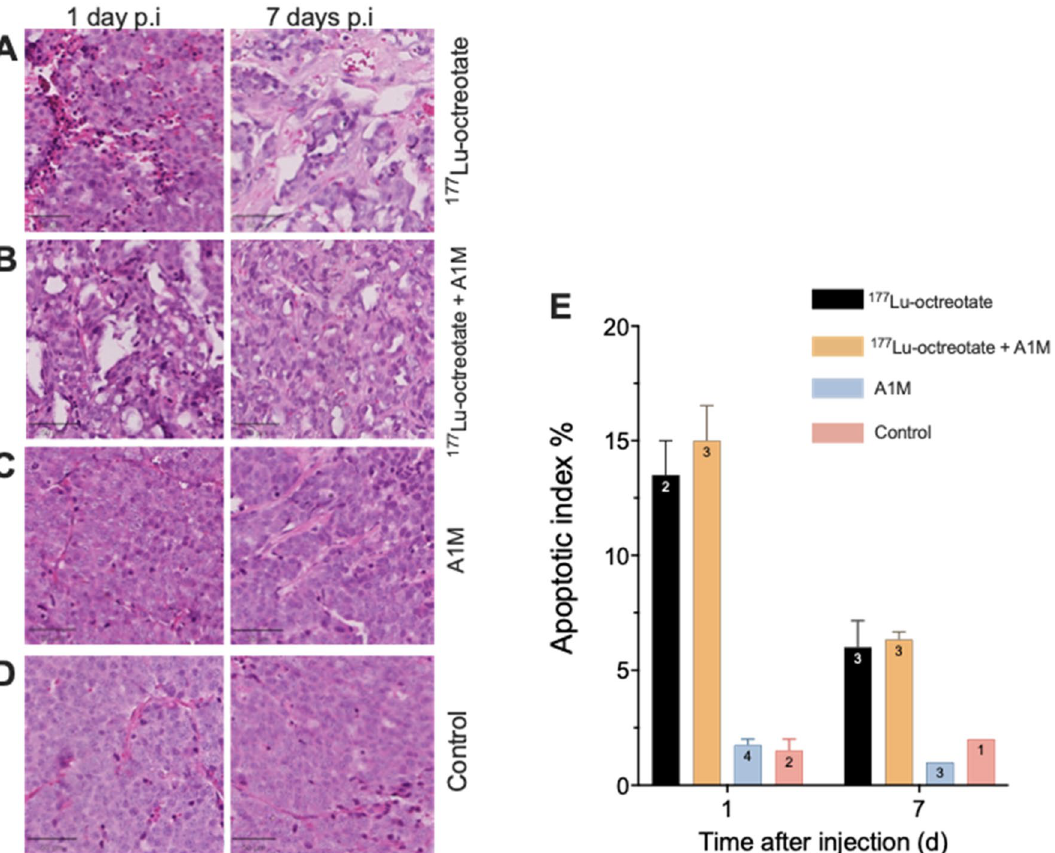
Figure 4. Sections of GOT1 tumors stained with H&E 1 and 7 days after injection of ( A ) 177 Lu-octreotate, ( B ) 177 Lu-octreotate + A1M, or ( C ) A1M, and ( D ) sham-treated controls. Black bar in bottom left corner corresponds to 20 µm. ( E ) Mean apoptotic index for each group at 1 and 7 days. Error bars represent SEM and sample size is written in the bars. Figure was produced using GraphPad Prism version 9.3.1 (https:// www. graph pad. com/ scien tific- softw are/